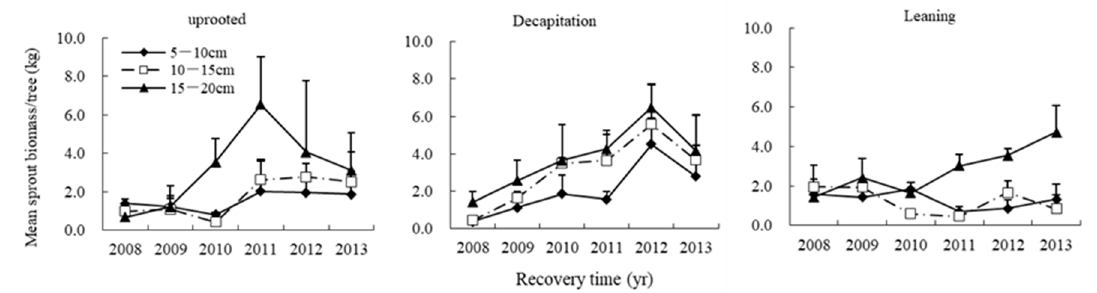
Figure 11. The annual dynamics of mean accumulative total sprout biomass for three diameter classes of uprooted, leaning and decapitation damaged trees.